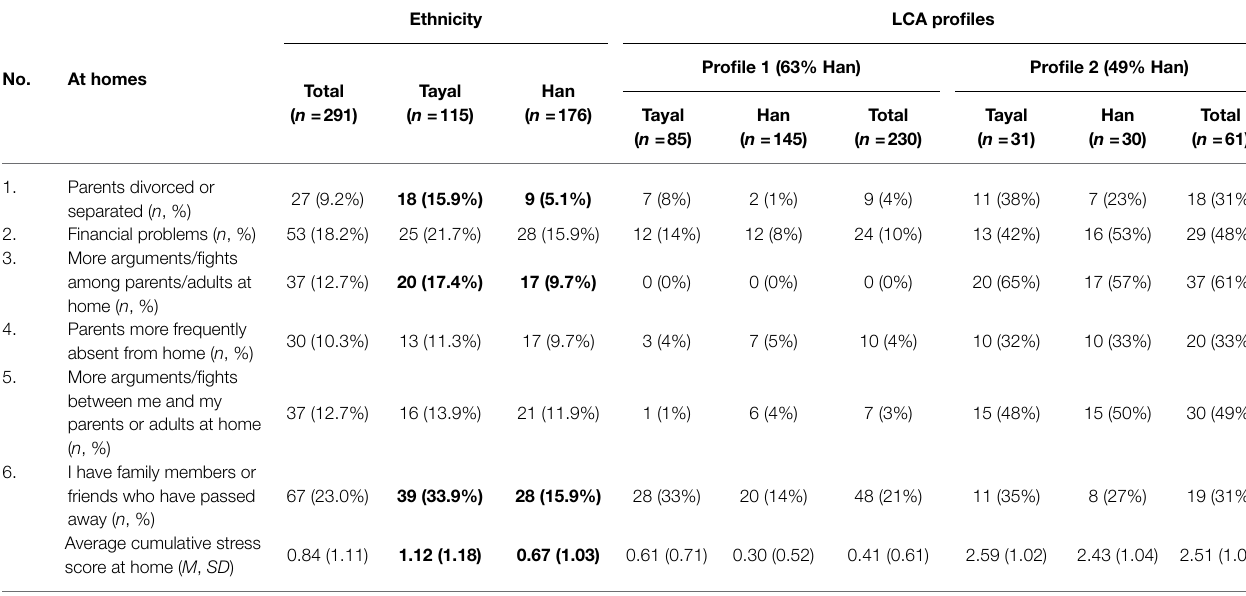
TABLE 3 | Descriptive information of stressful life events experienced at home by ethnicity and LCA profiles.